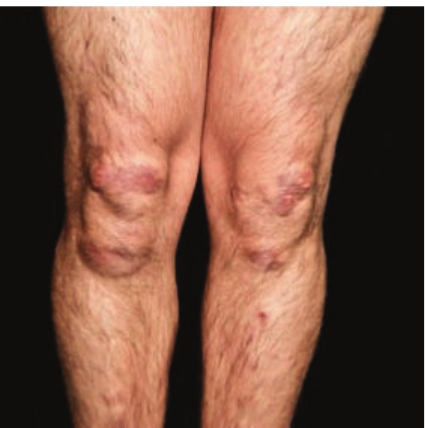
Figure 1: Bilateral lower extremities demonstrating multiple firm, nontender nodules over the knees and shins with overlying yellow plaques.